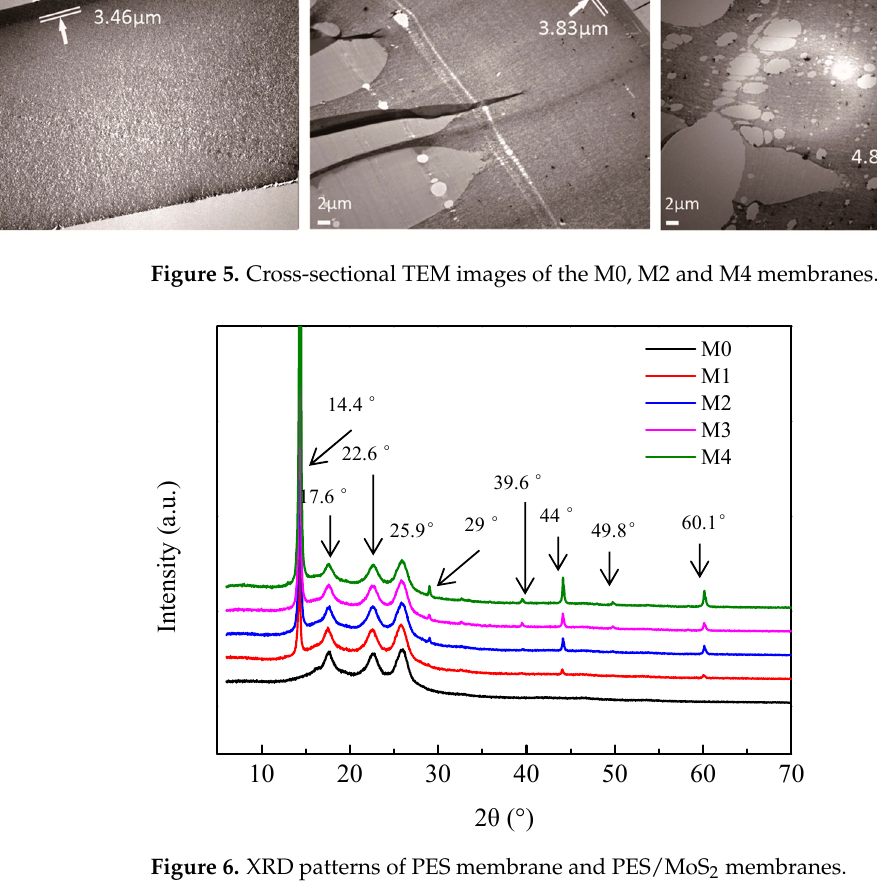
Table 2. Effect of different concentrations of 2D MoS 2 on membrane porosity, mean pore radius, and water